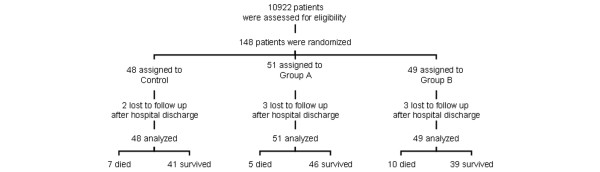
Study flow chart.